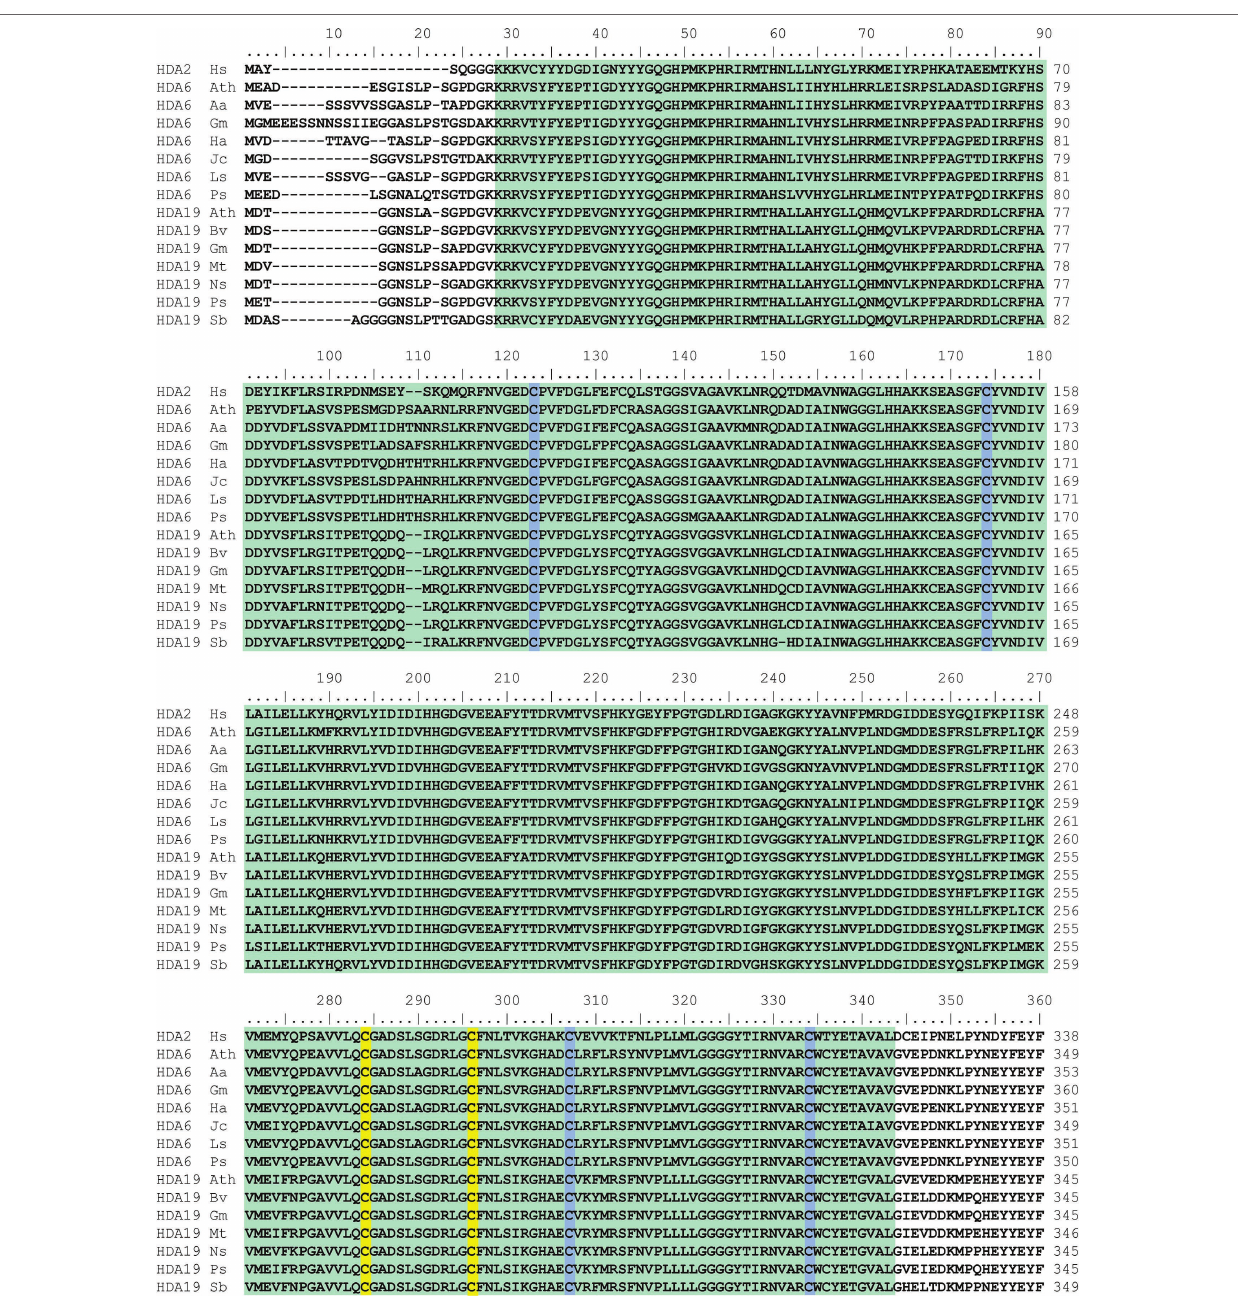
FIGURE 2 | Alignment of the amino acid sequences of the HDA domain of human HDA2 and different plant histone deacetylase 6 and 19 proteins. HDA amino acid sequences were aligned using Clustal W. The HDA domain is depicted in green. Cysteine residues of human HDA2 which are targets for S-nitrosation and the corresponding cysteine residues of plant HDAs are highlighted in yellow. Other conserved cysteine residues are marked in blue. Hs, Homo sapiens NP_001518.3; Ath, Arabidospsis thaliana AED97705.1 (HDA6) and O22446.2 (HDA19); Aa, Artemisia annua PWA92260.1; Gm, Glycine max XP_003525556.1 (HDA6) and XP_003543935.1 (HDA19); Ha, Helianthus annuus XP_021978414.1; Jc, Jatropha curcas XP_012079994.1; Ls, Lactuca sativa XP_023740973.1; Ps, Papaver somniferum XP_026387130.1 (HDA6) and XP_026455725.1 (HDA19); Bv, Beta vulgaris XP_010690952.1; Mt., Medicago truncatula XP_013462369.1; Ns, Nicotiana sylvestris XP_009770456.1; Sb, Sorghum bicolor